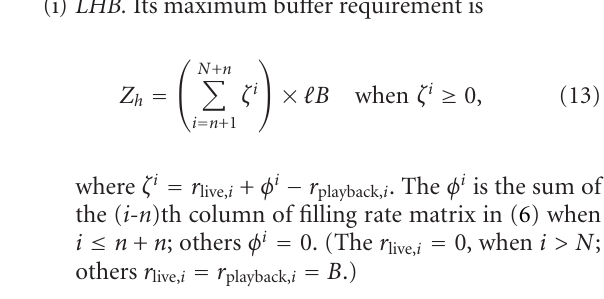
(cid:16) T f r dt is the size of missing video segments. If T T a filling